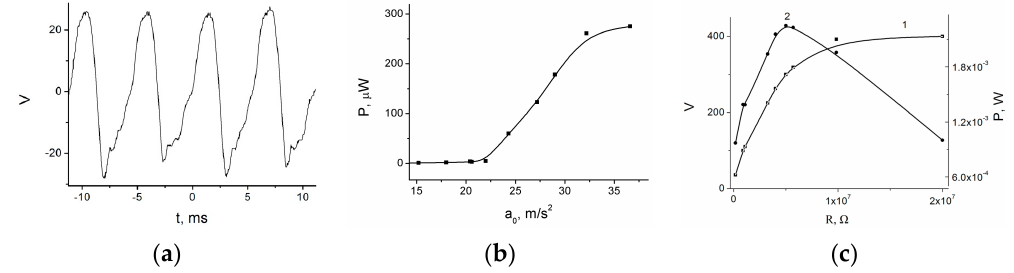
Figure 9. Experimental investigations of the impact out-of-plane electret generator: ( a ) generated voltage as a function of time in the impact mode ( V P = 110 V, S = 2.9 cm 2 , a 0 = 22 m/s 2 , R = 10 7 Ω ); ( b ) output power as a function of the external vibrations acceleration amplitude ( V P = 110 V, S = 2.9 cm 2 , R = 10 7 Ω ); and ( c ) load curves of the generator: 1 — V ( t ), 2 — P ( t ) ( V P = 230 V, S = 6 cm 2 , a 0 = 50 m/s 2 ).